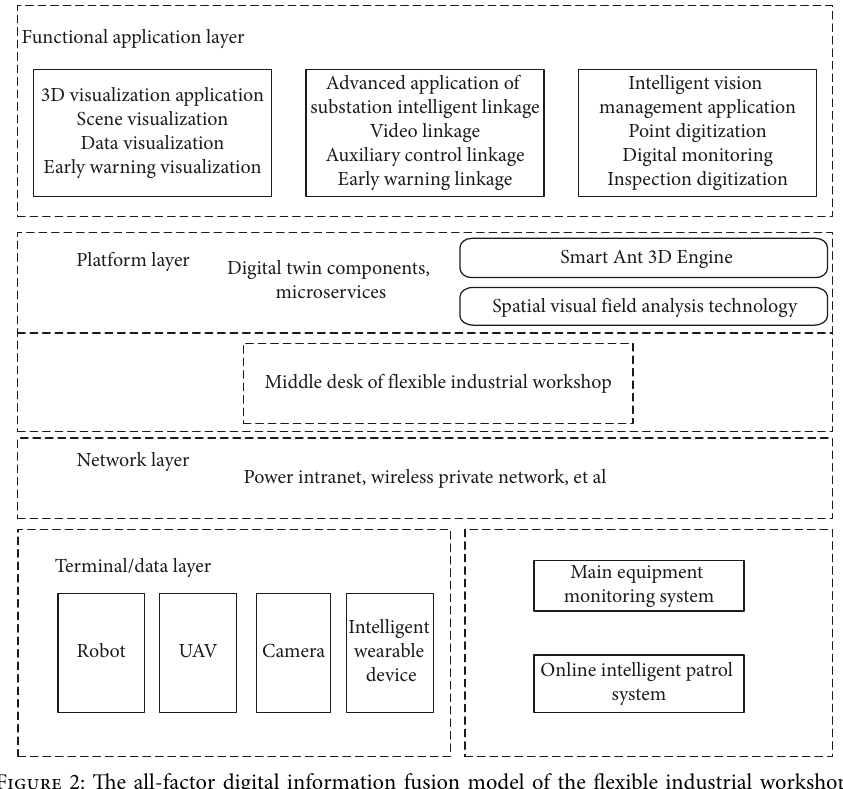
Figure 2: The all-factor digital information fusion model of the flexible industrial workshop.